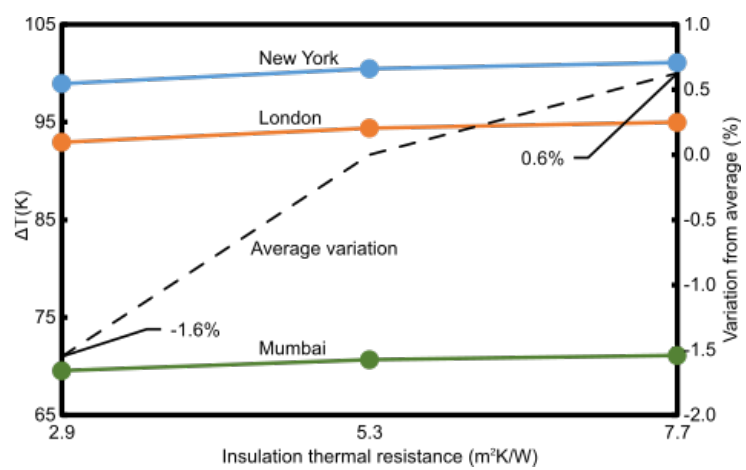
Figure A1. Sensitivity of the problem to the thermal resistance of the Figure 11. Sensitivity of the problem to the thermal resistance of the insulation.